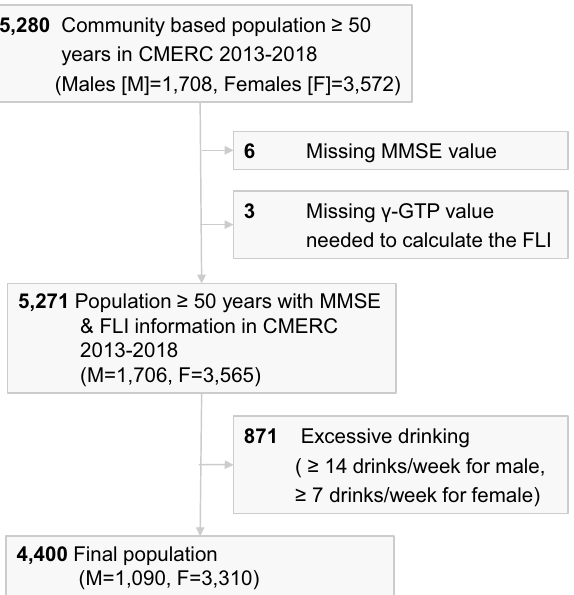
Figure 2. Flowchart of the study population. CMERC, cardiovascular and metabolic diseases etiology research center; MMSE, mini-mental status examination; FLI, fatty liver index; γ-GTP, gamma-glutamyl